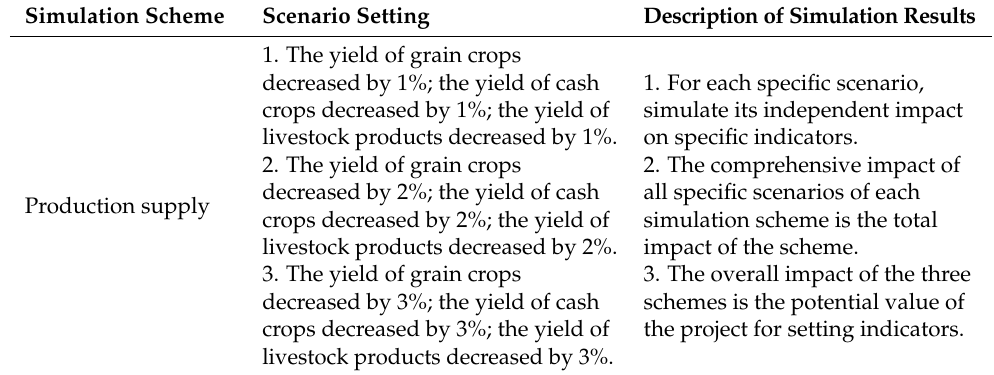
Table 3. Simulation scheme and scenario